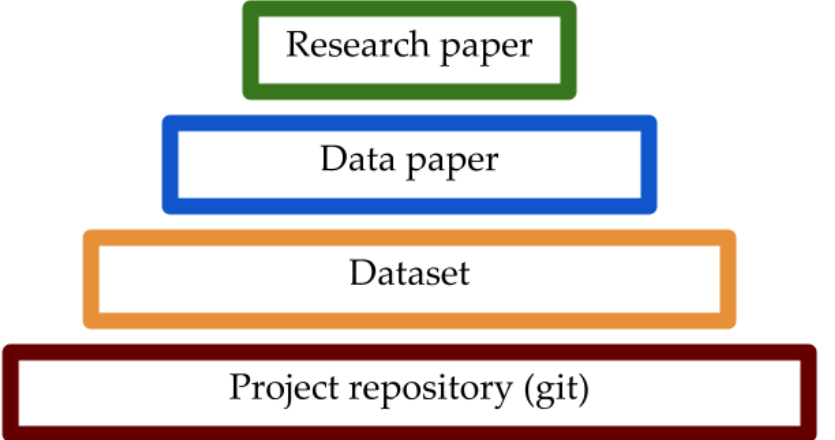
Figure 1. The pyramid structure of the research and dissemination ecosystem in data-driven projects adapted from